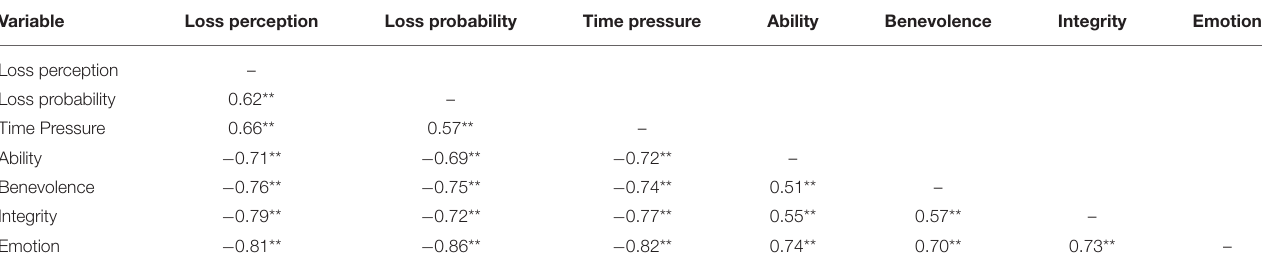
TABLE 3 | Overall correlation analysis.